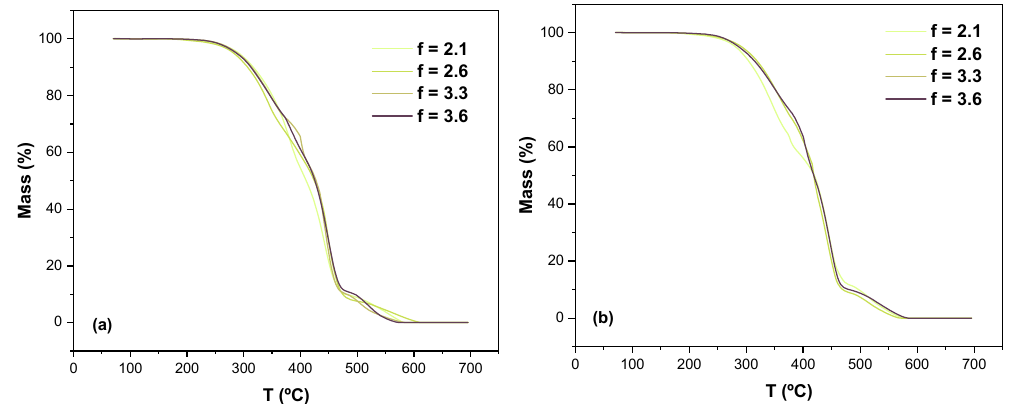
Figure 12. HNIPUs TGA analysis. ( a ) HNIPUs (H 2 O), ( b ) HNIPUs (EtOH) .